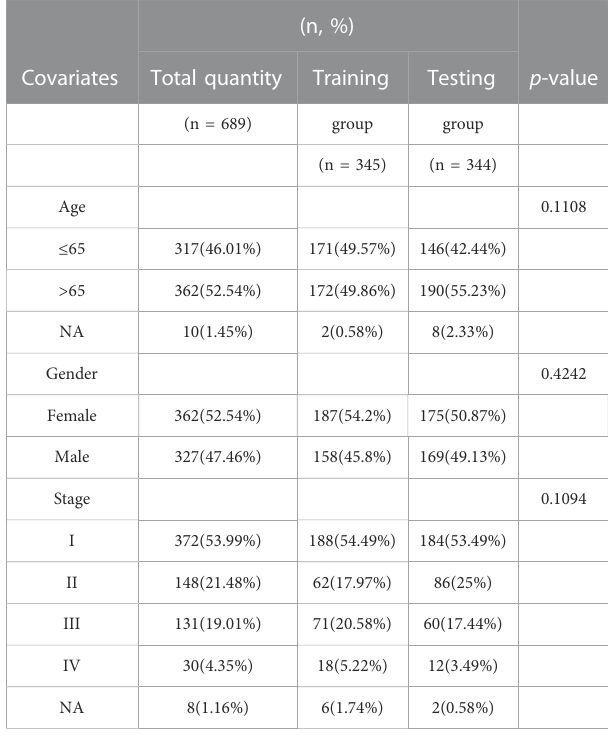
TABLE 2 Clinical characteristics analysis of